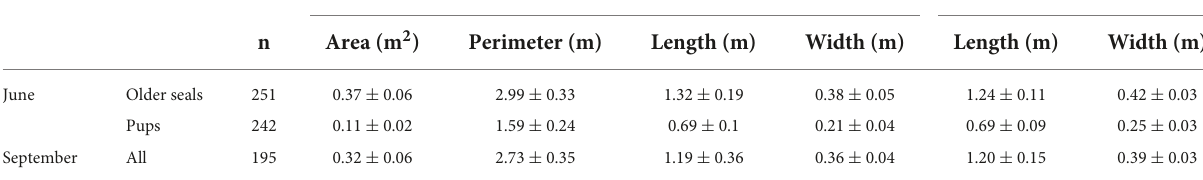
TABLE 4 Average body sizes of harbour seals hauled out on land calculated from drone orthomosaics during pupping season in June and September